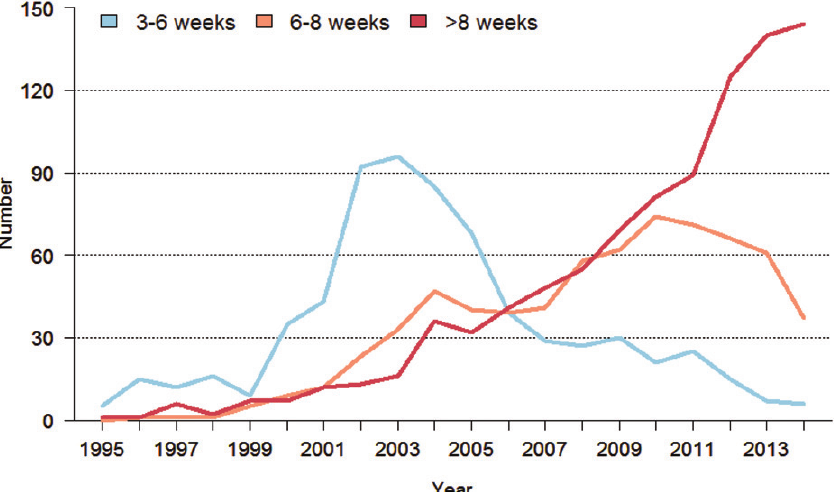
Figure 2. Time in weeks for patients treated in Sweden 1995 – 2014 with short-course radiotherapy (scRT) and a delay to surgery ( > 3 weeks). When a delay started to be used in 1999, the time when the Stockholm III trial (47) started, the delay was usually 4 – 6 weeks. After a few years, a delay of 6 – 8 weeks or longer became more common, and during the last years it was above 8 weeks in the majority of the patients.